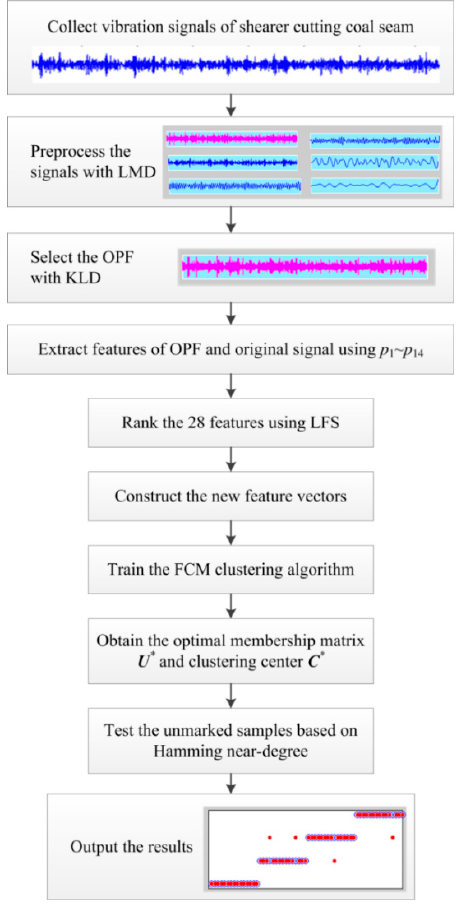
Figure 1. Flowchart of the proposed method.